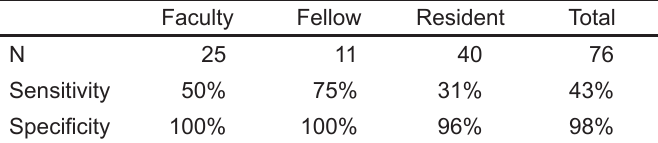
Table 2. Sensitivity and specificity by level of